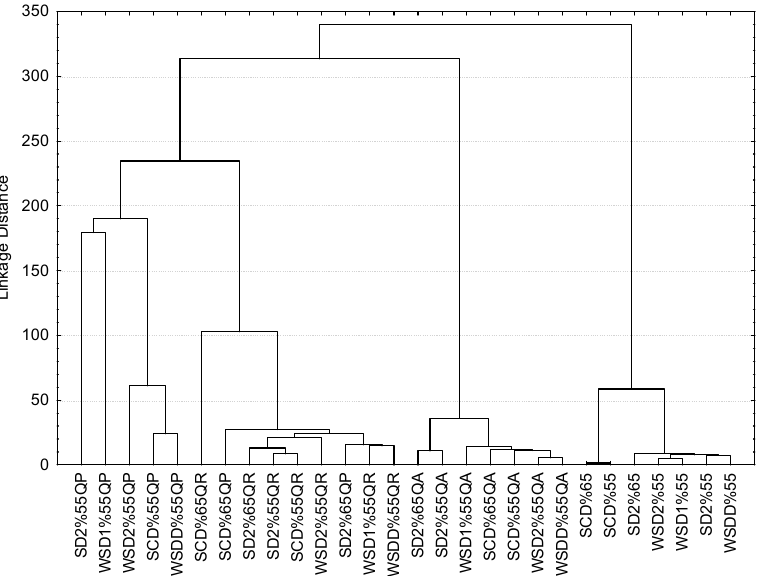
Figure 1. Tree graph representing the cluster analysis of the brandies applied to color and TPI data. Clustering of the brandies in contact with Quercus robur (QR) is observed, while the two brandies aged in Quercus petraea (QP) at 65% ABV can also be found among them. These samples are the closest to the remaining brandies aged in Quercus petraea (QP) casks. Those aged in Quercus alba (QA) are slightly further apart with the grouping at the greatest distance being reserved for non-aged spirits. By plotting these values on the a*-b* and L*-TPI planes (Figure 2), several conclusions can be